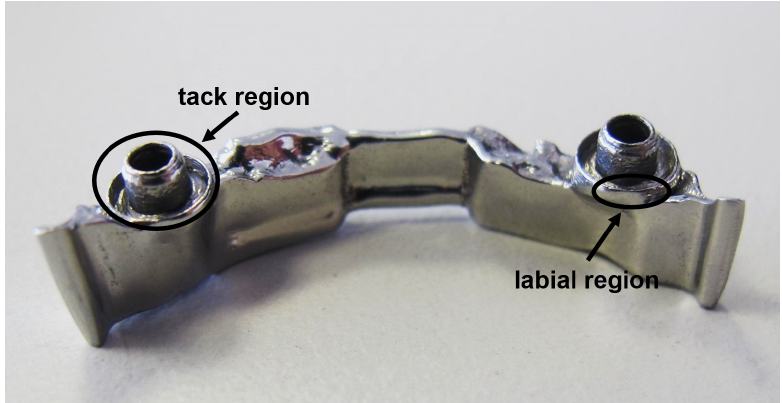
Figure 1. SLM fabricated dental